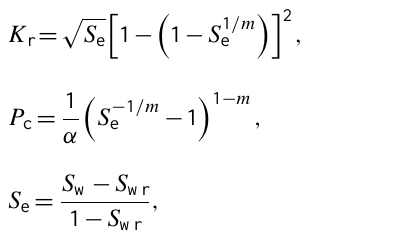
28 C m − 3 for the loam following the experimental relation- ship of Jardani et al. (2007) for a saturated medium. We use Eq. (5) to model ¯ Q v (S w )